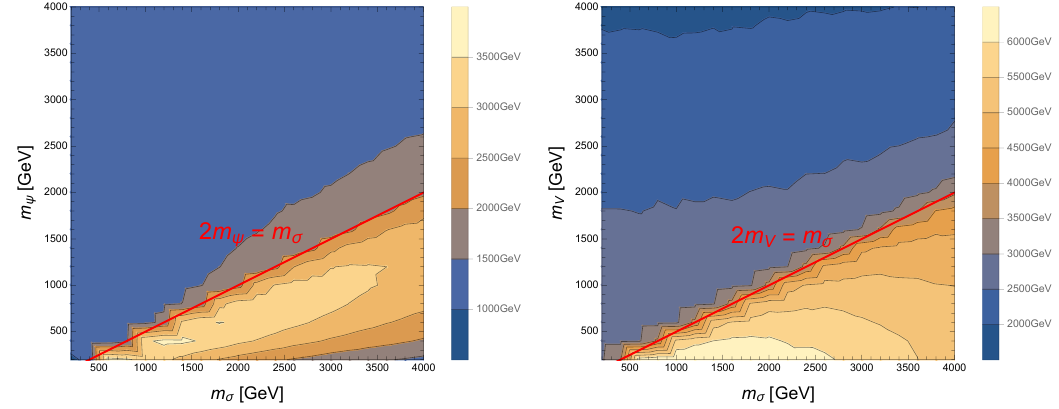
Figure 10 . Sensitivity of a 100 TeV future proton-proton collider to the dilaton portal dark matter model considered in this work, for the case of Majorana (left panel) and vector (right panel) dark matter. The results are presented in the ( m (cid:27) ; m (cid:9) ;V ) plane and we indicate, through the colour coding, the expected reach on the theory cuto(cid:11) scale f . Our (cid:12)ndings correspond to integrated luminosity of 3 ab (cid:0) 1